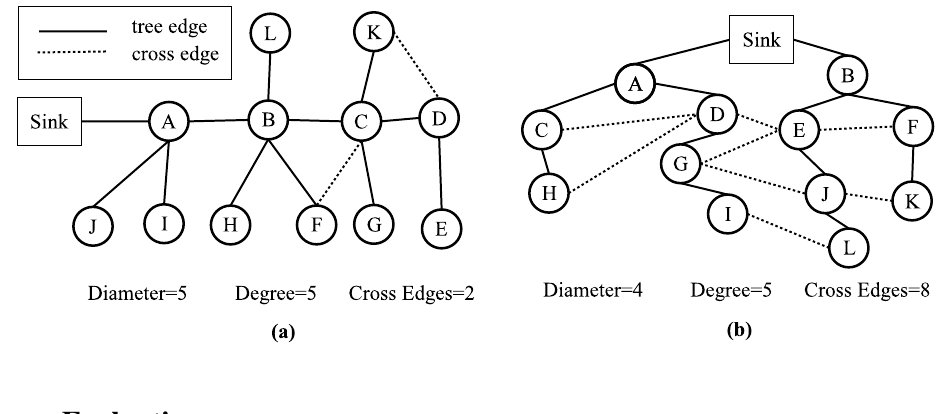
Figure 6. ( a ) Caterpillar-like graph; ( b ) random dense graph.